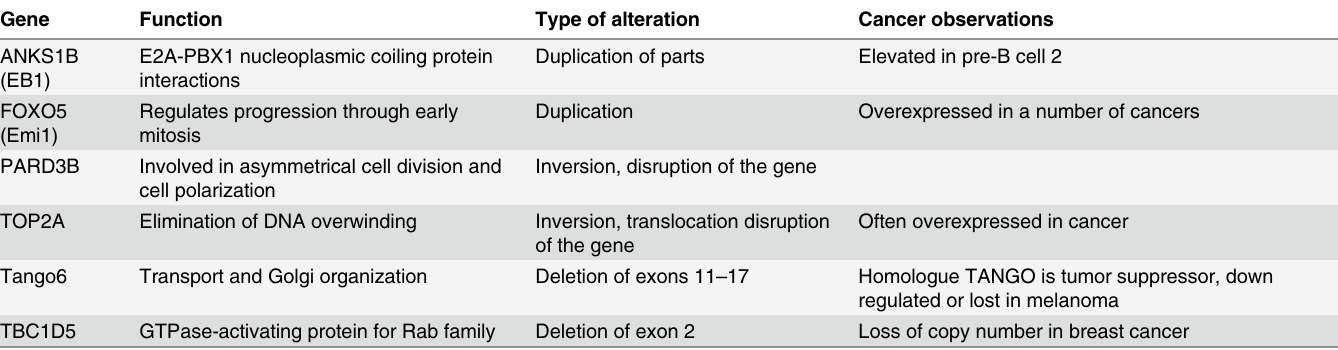
Table 1. Genes affected in TOP2A overexpressing